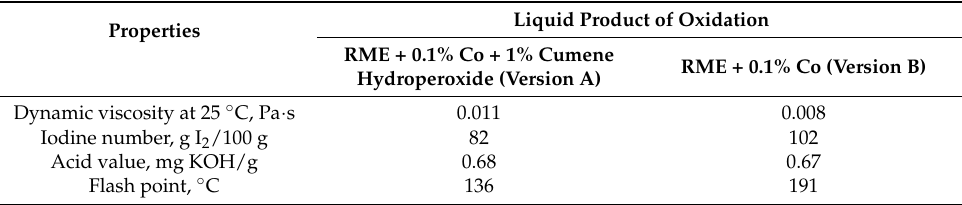
Figure 2. Changes in peroxide ( a ) and acid ( b ) value of rapeseed oil methyl ester vs. time of oxidation. Table 3. Physicochemical properties of the oxidation of liquid products.